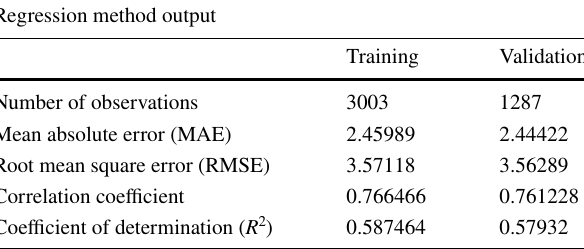
Table 7 Regression WAG incremental recovery factor